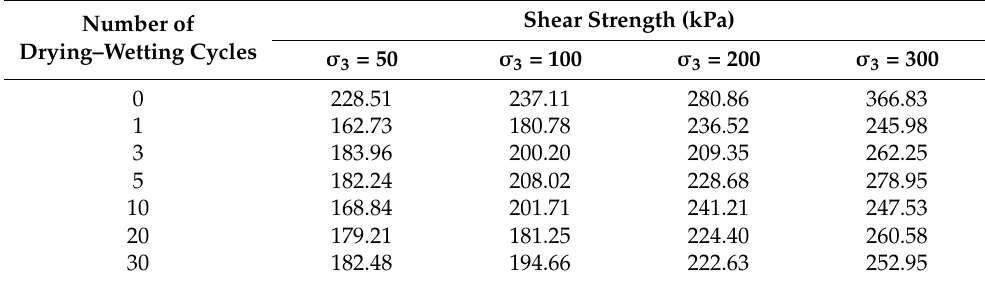
Table 6. Shear strength.